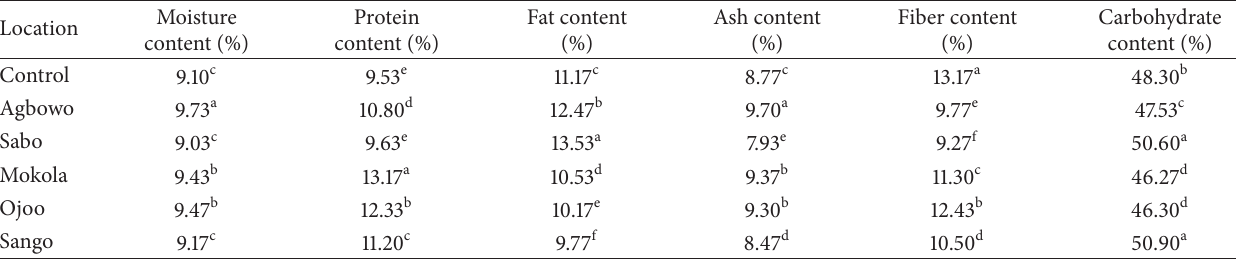
Table 1: Proximate analysis of “Suya spices.”